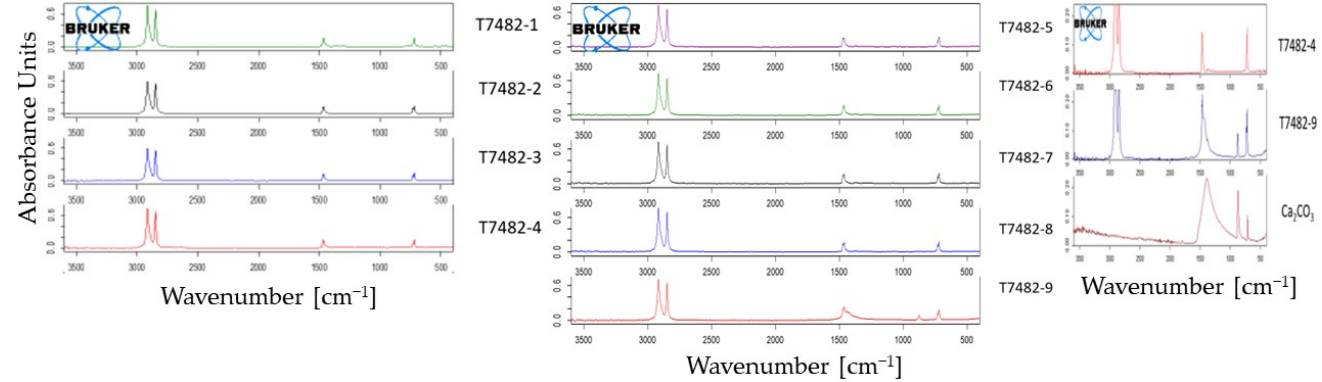
Figure 11. ATR-FTIR spectra of membranes of pure PE ( left ) and regenerated PE ( middle ). Spectra of a membrane of pure PE ( left ) compared with regenerated ( middle ) are overlayed with a spectrum of reference calcium carbonate to identify the additional peaks attributed to the inorganic filler material ( right ).